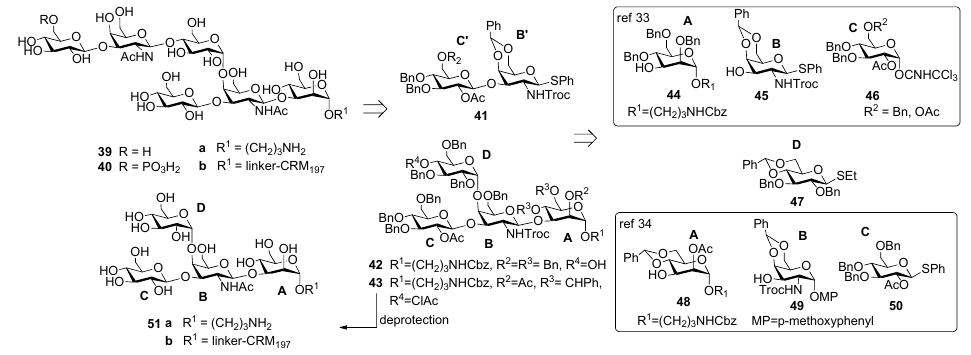
Figure 5. C. difficile PSII synthetic fragments reported in [33,34].